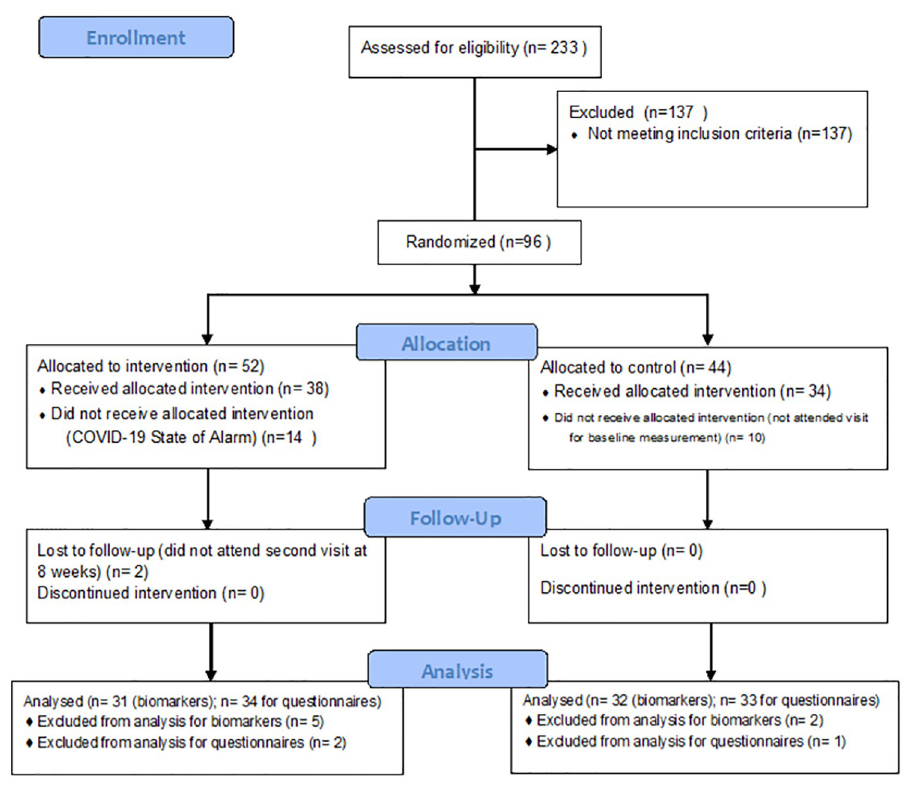
Fig 1. Study flow